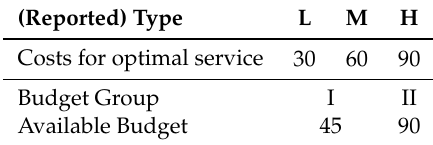
Table 5. Assignment of budget groups and costs for optimal number of